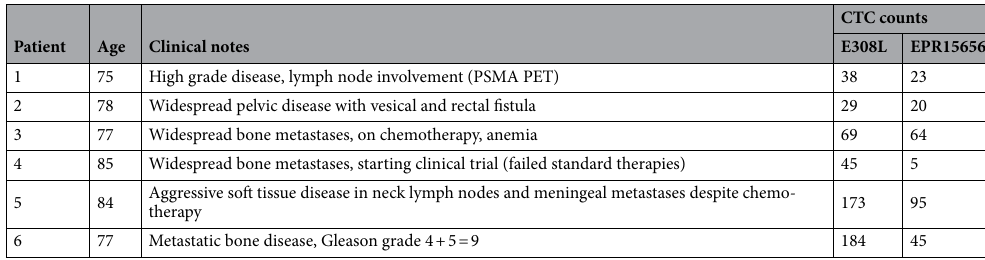
Table 1. AR-V7 staining CTC detection by antibody in advanced CRPC patients. CTCs were enriched (RosetteSep) and immunocytostained for detection. Nucleated (Hoechst staining) events were included in CTC counts if negative for CD45 and positive for AR-V7 using the indicated anti-AR-V7